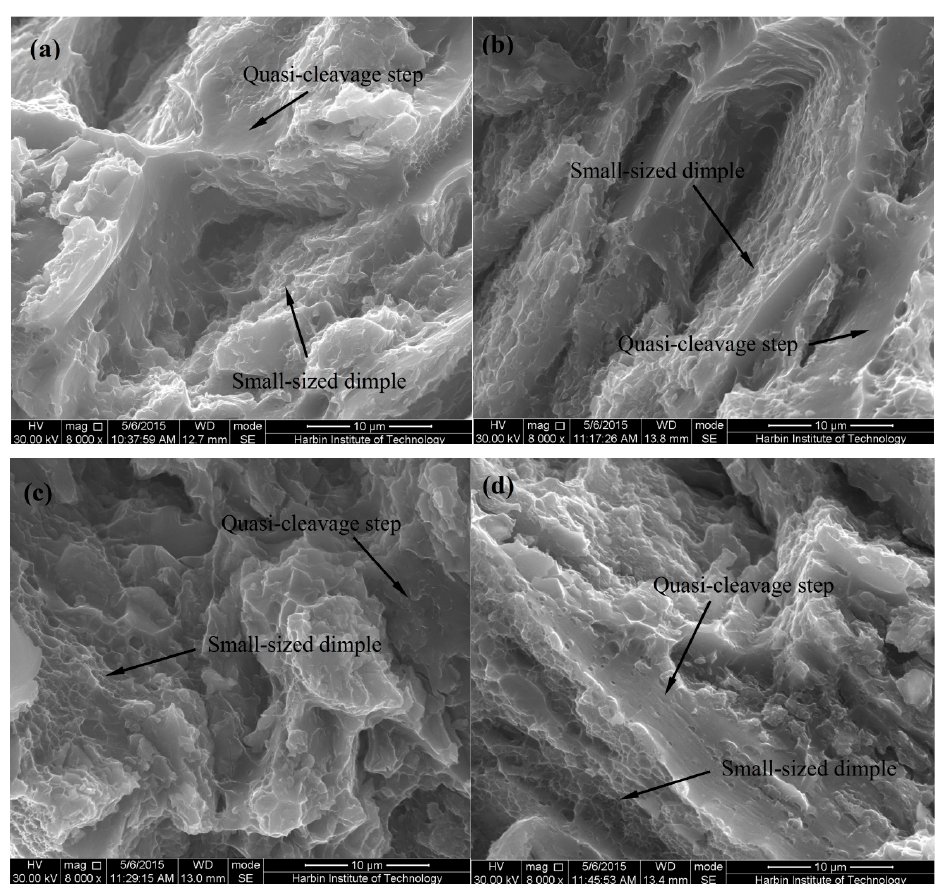
Figure 13. Tensile fracture at the bottom of the thixoformed parts soaked for 10 min at different remelting temperatures: ( a ) 580 °C, ( b ) 590 °C, ( c ) 600 °C, and ( d ) 610 °C.